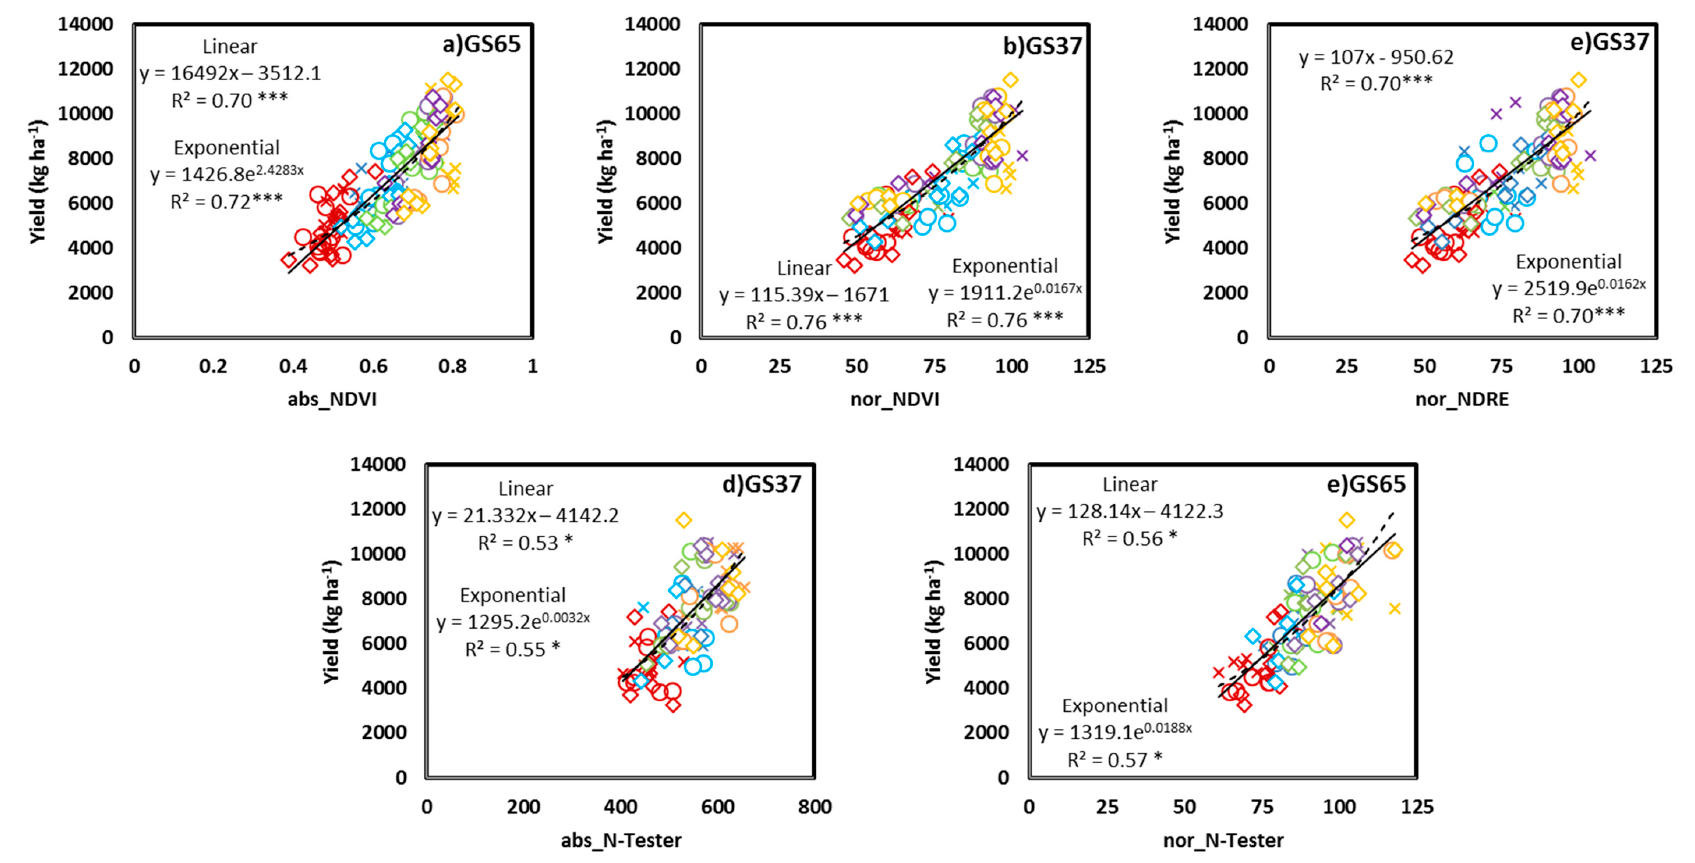
Figure 6. Relationship between the yield (kg ha − 1 ) and abs_NDVI values at GS65 ( a ), nor_NDVI at GS37 ( b ), nor_NDRE at GS37 ( c ), abs_N-Tester at GS37 ( d ), and nor_N-Tester at GS65 ( e ). Two models were fitted: linear, solid line; exponential, dashed line. *, *** Significant at 0.05 and 0.001 probability levels, respectively. Initial fertilizers: ×, conventional; o , dairy slurry; ◊ , sheep manure. N rate at GS30: red, +0N; blue, +40N; green, +80N; purple, +120N; orange, +160N. abs, absolute values; nor, normalized values; NDVI, Normalized Difference Vegetation Index; NDRE, Normalized Difference Red Edge Index.